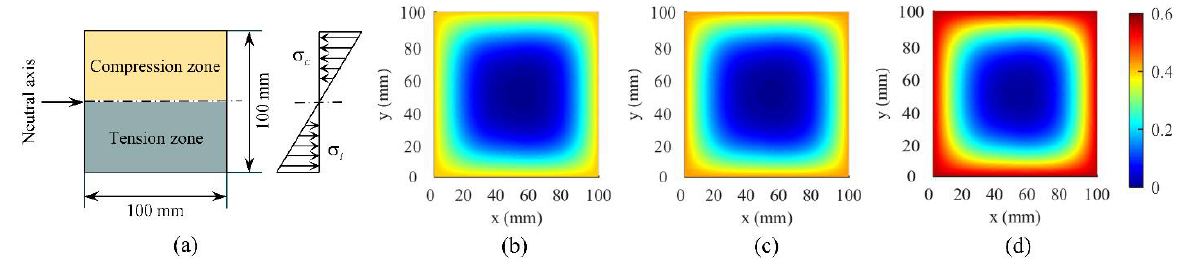
Figure 15. Comparison between the statistical results of the 3D RTCA model, test value, and FSL analytical solution: ( a ) section size and stress distribution; ( b ) w / c = 0.35; ( c ) w / c = 0.4; ( d ) w / c = 0.45.